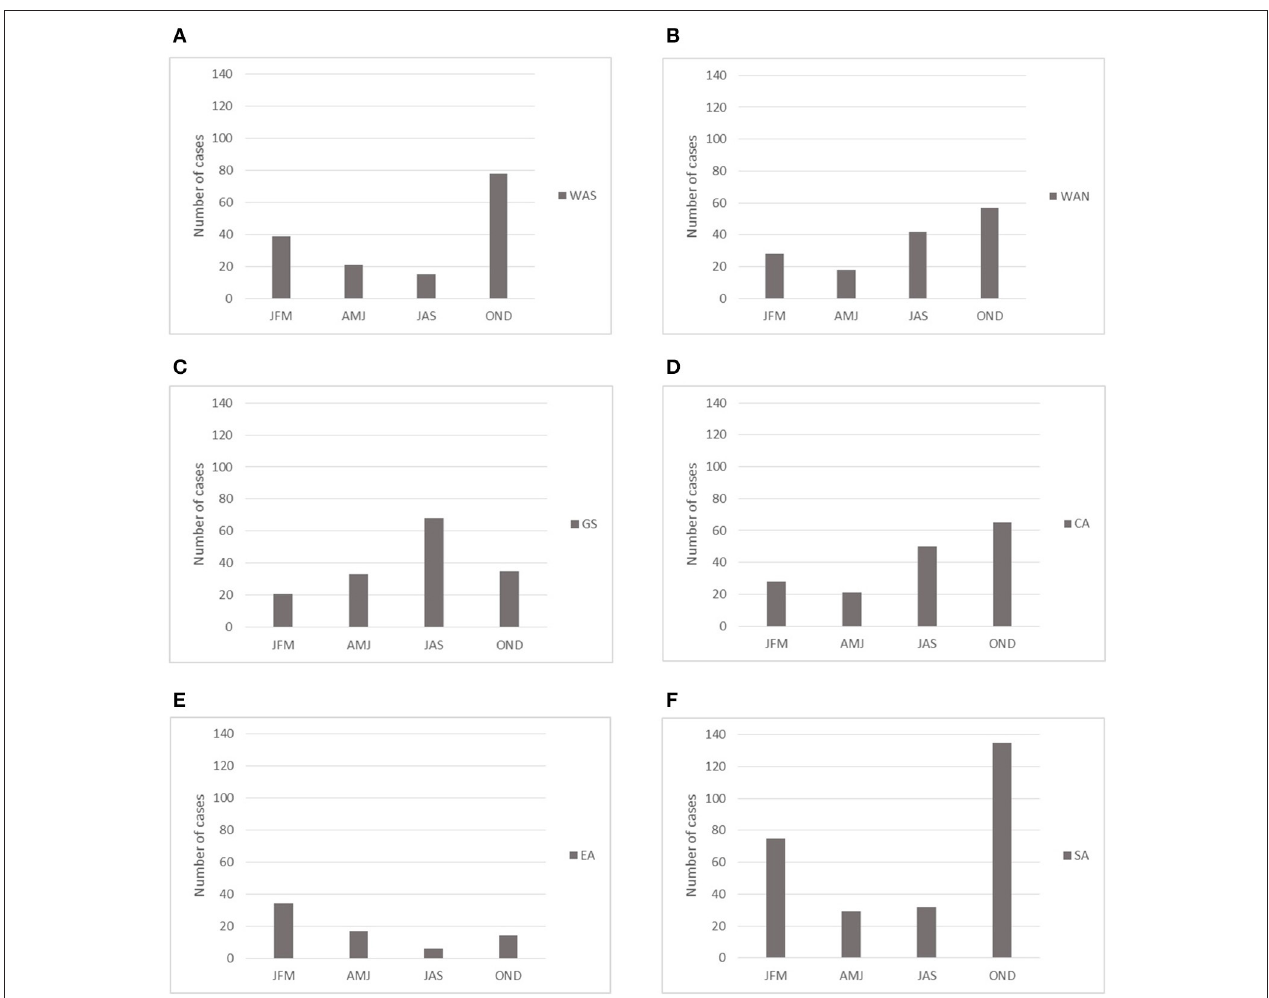
FIGURE 5 | Number of cases for each quarter for the subregions defined in Figure 1, for 1998–2012, where: (A) WAS, (B) WAN, (C) GS, (D) CA, (E) EA, (F) SA.